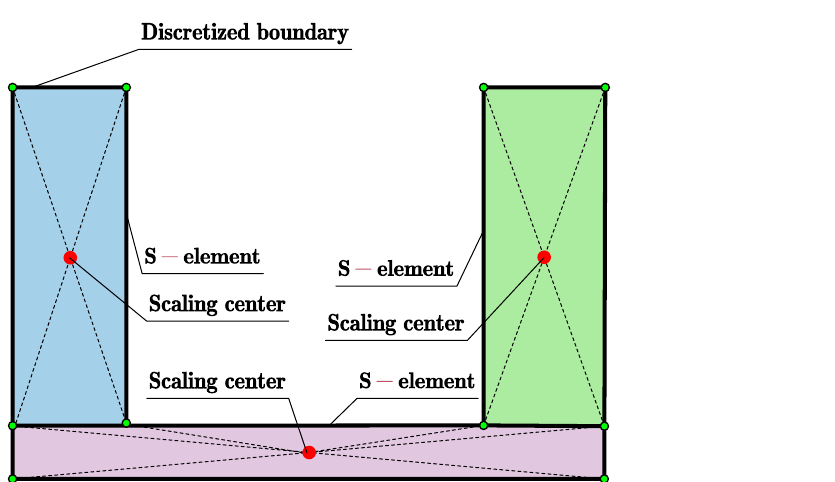
Figure 2. Bounded domain divided by three